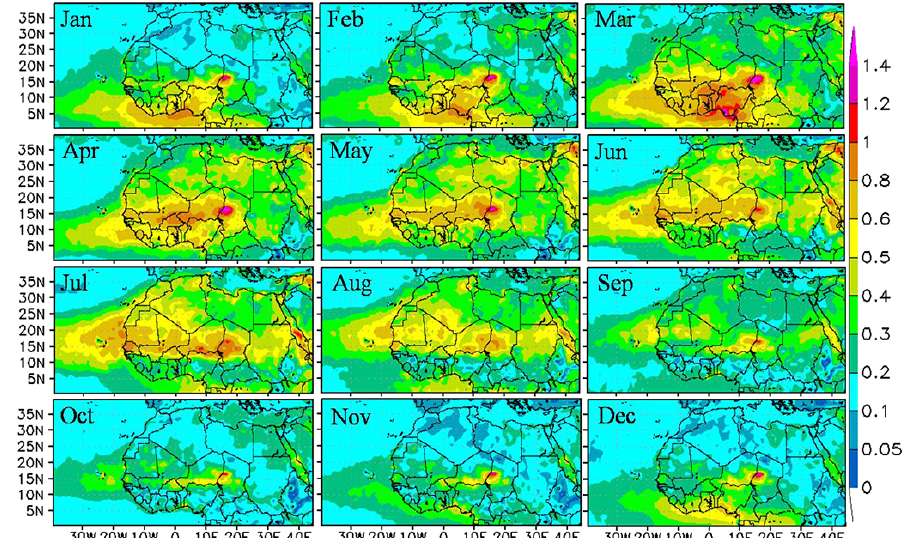
Figure 10. Monthly aerosol optical thickness derived from the combination of the standard and Deep Blue products applied to Aqua-MODIS data over northern Africa for the 2006–2010 period.